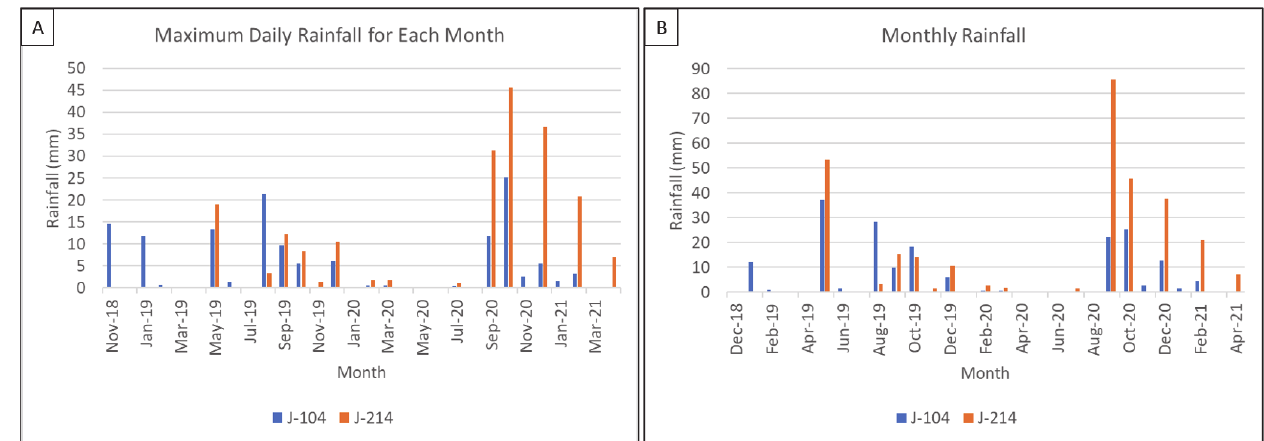
Figure 4. Rainfall data for station J ‐ 104 and J ‐ 214: ( A ) maximum daily rainfall for each month; ( B ) monthly rainfall.